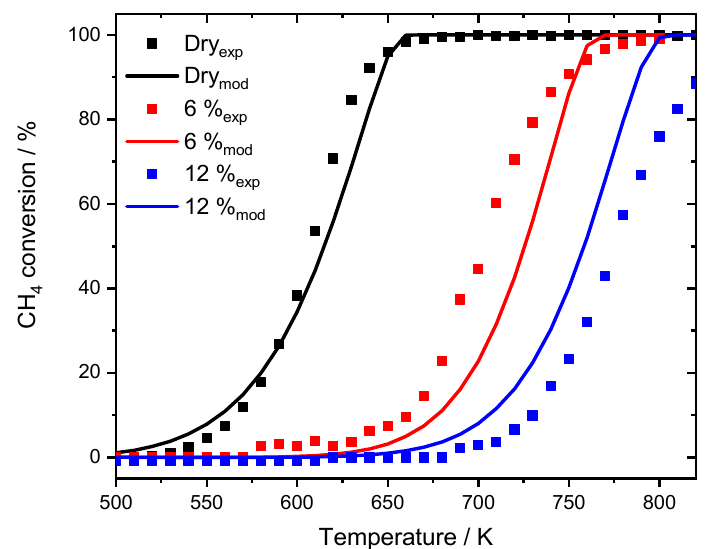
Figure 9. Light-off experiments conducted with the SpaciPro setup for 3200 ppm CH 4 , 10% O 2 in N 2 with different amounts of externally dosed water. Shown is the experiment in absence of water (black dots), the affiliated model (black line), as well as results for 6% H 2 O (exp: red dots, sim: red line) and for 12% H 2 O (exp: blue dots, sim: blue line). GHSV = 30,000 h − 1 .